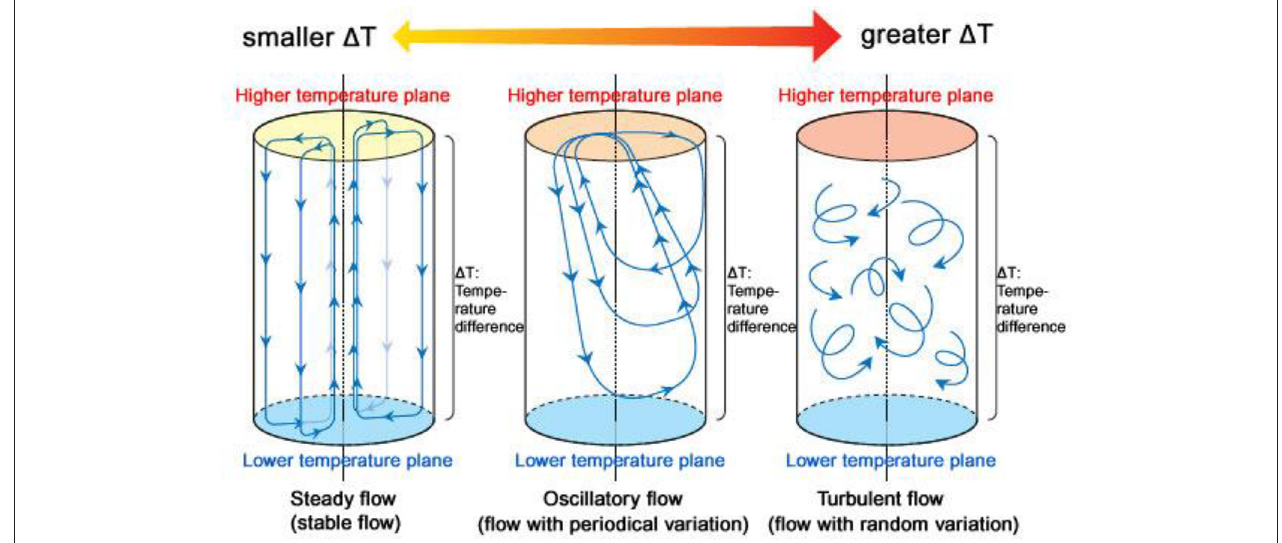
FIGURE 2 | The temperature effect on B-M flow pattern. The initial steady flow turns into a flow with periodical variations called an oscillatory flow, and then the flow becomes completely disordered named a turbulent flow with an increase of temperature difference 1 T (Yoda,